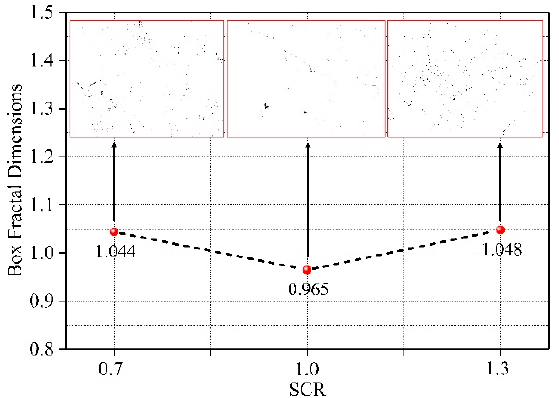
Figure 10. The influence of SCR on fractal dimension.